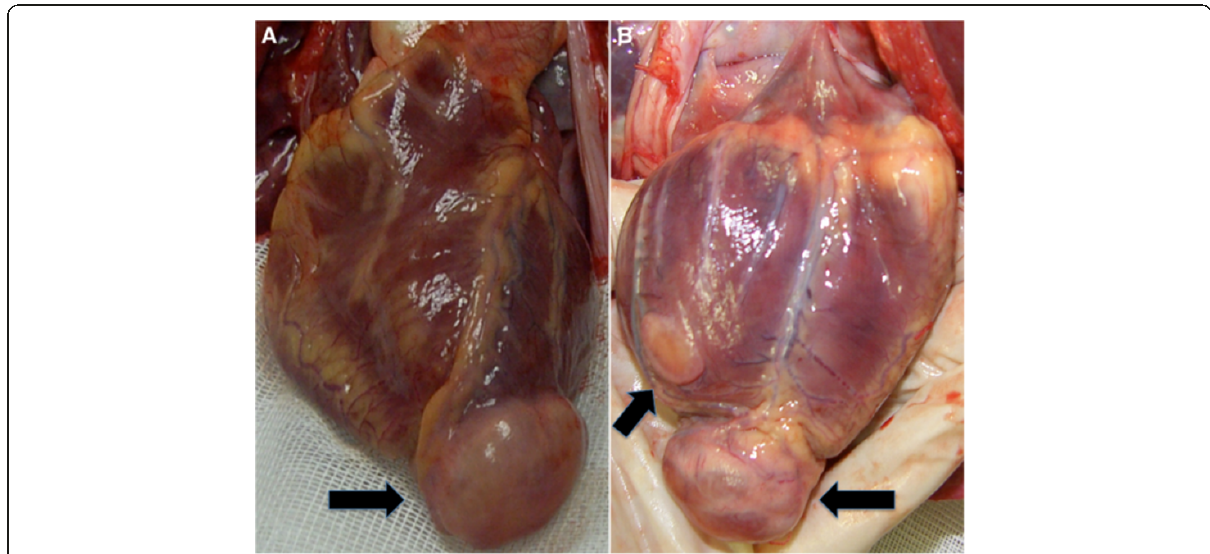
Figure 1 Microscopic findings. The peduncolated mass at the cardiac apex measured 4,5 × 3 × 2cm ( A ). A second superficial subepicardial neoformation on the posterior wall of the left ventricle, measured 2 × 1,5 × 1cm ( B